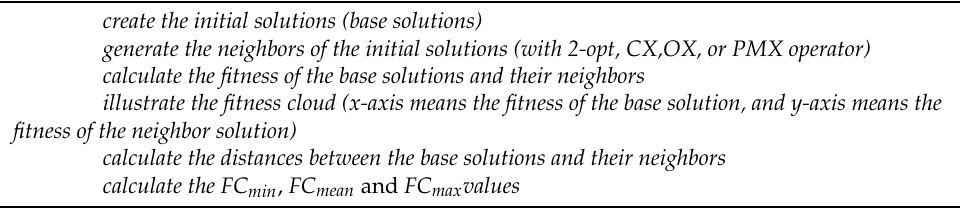
Table 3. Calculation of the key